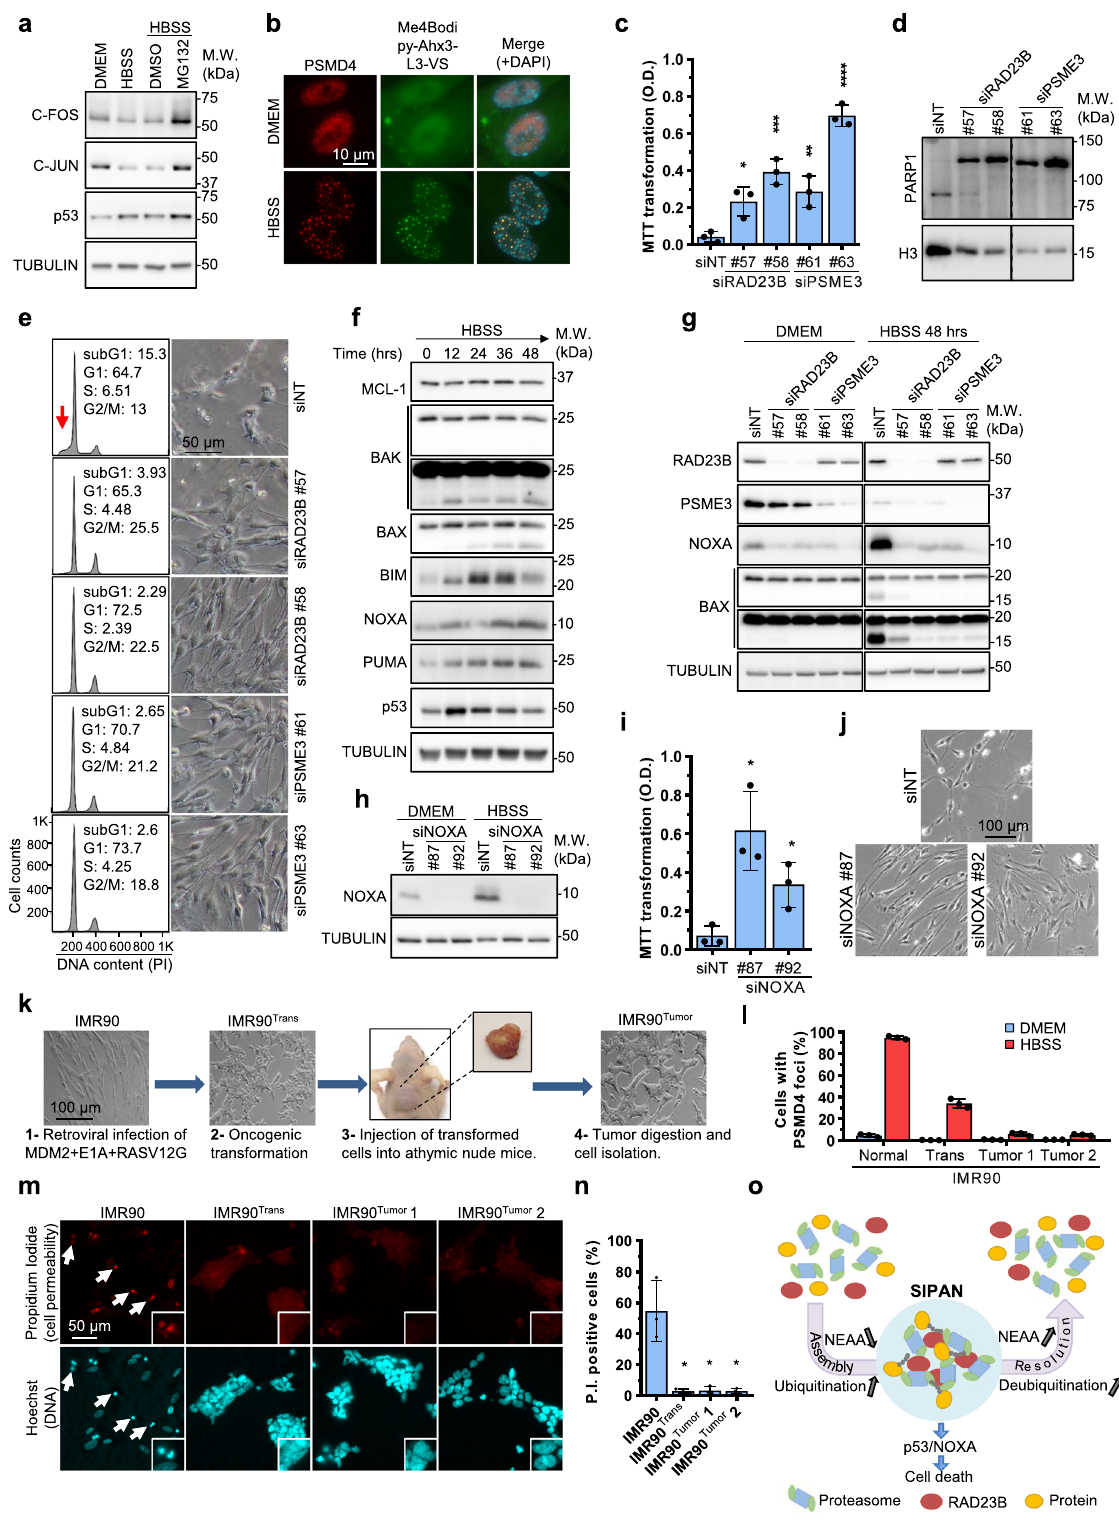
Analysis of cell death using propidium iodide/Hoechst 33342 . After 96 hrs incubation with HBSS, IMR90, and IMR90 tumor cells were incubated for 1hr with 1µg/ml propidium iodide and 1µg/ml Hoechst 33342. Cells were washed, fi xed with PBS containing 3% PFA and analyzed by fl uorescence microscopy as described above. Real-time quantitative PCR . Expression levels of mRNAs encoding protein shuttling factors siRNA were analyzed as described before 70 . The mRNA levels